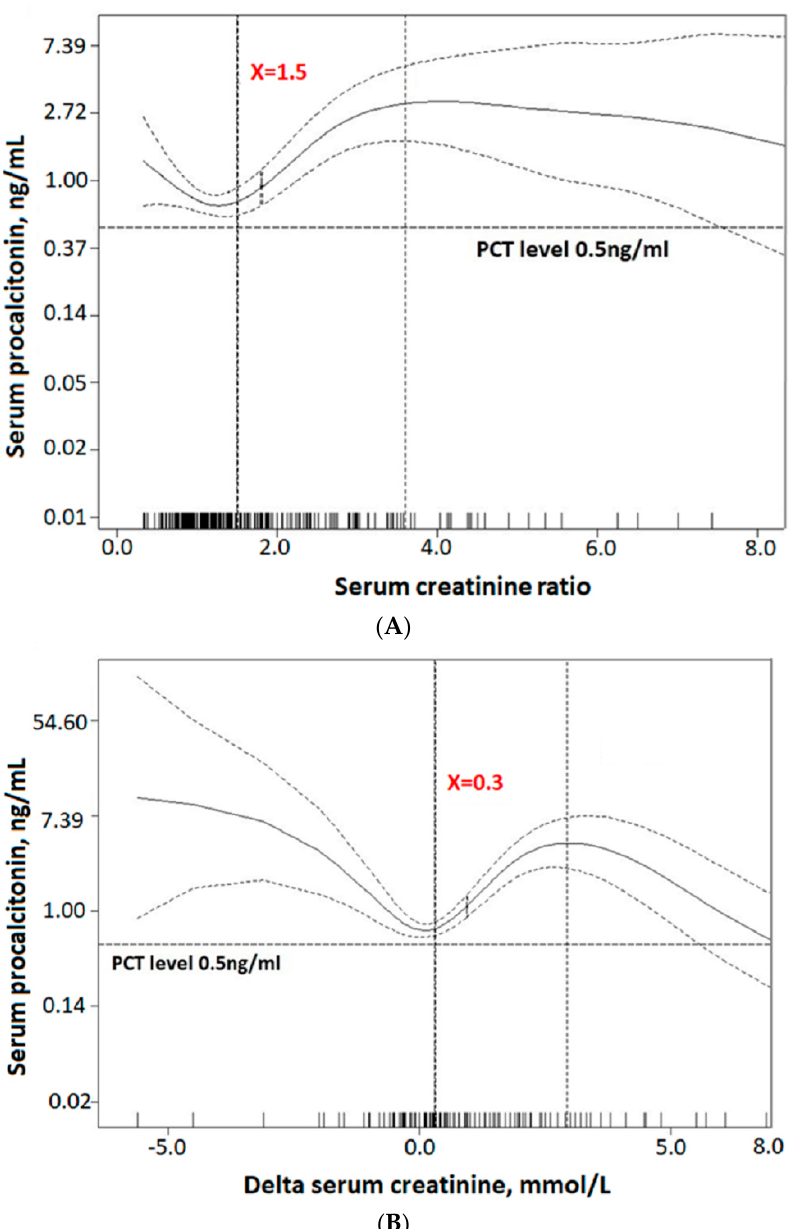
Figure 1. Generalized additive model plots showing the trends of PCT changes along with the increase in ( A ) SCr ratio, and ( B ) delta SCr. Abbreviations: SCr = serum creatinine; PCT = procalcitonin.